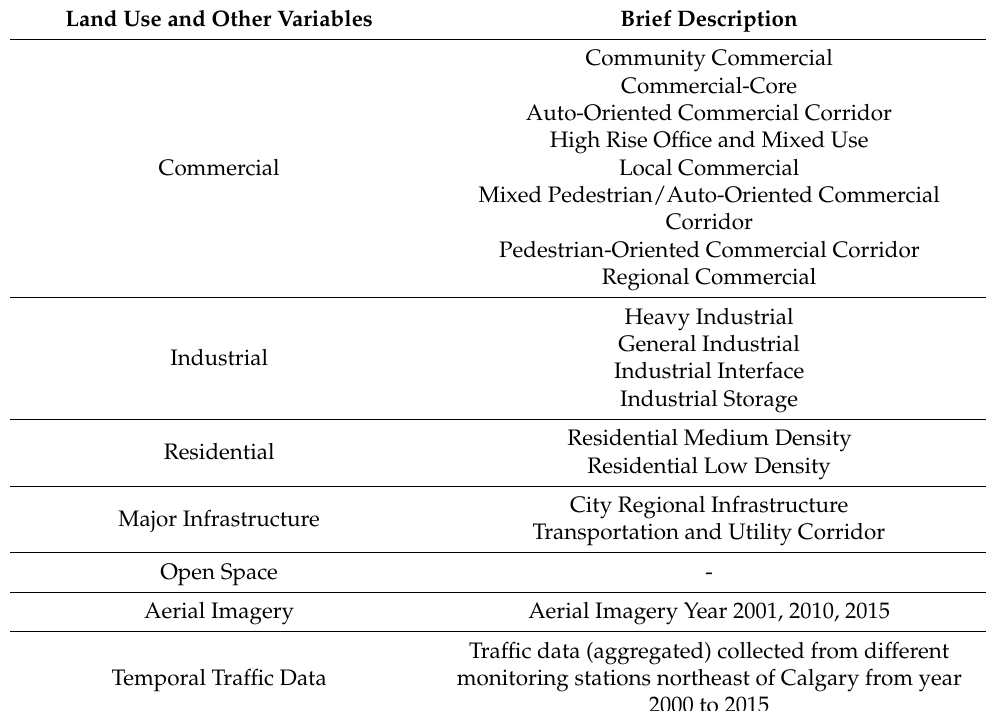
Figure 1. The geographic study area: northeast Calgary. The original land use datasets were obtained from the University of Calgary, derived from the City’s Land Use Bylaw Code classification of Urban Land Use and Planning Standards of Development Land. The designated land use classes are shown in Table 1. Table 1. This table is based on the “Land Use Bylaw Code” for Classification of Urban Land Use and Planning Standards of Development, City of